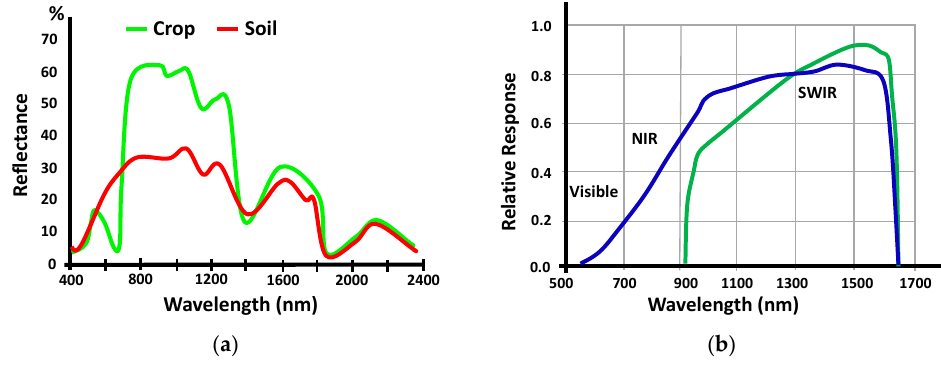
Figure 5. ( a ) Typical spectral reflectance profiles for crops and soil roughly drawn from the information provided in [34]; ( b ) Relative response from two generic sensors covering Near-Infrared (NIR) and Short-Wave infrared (SWIR) spectral